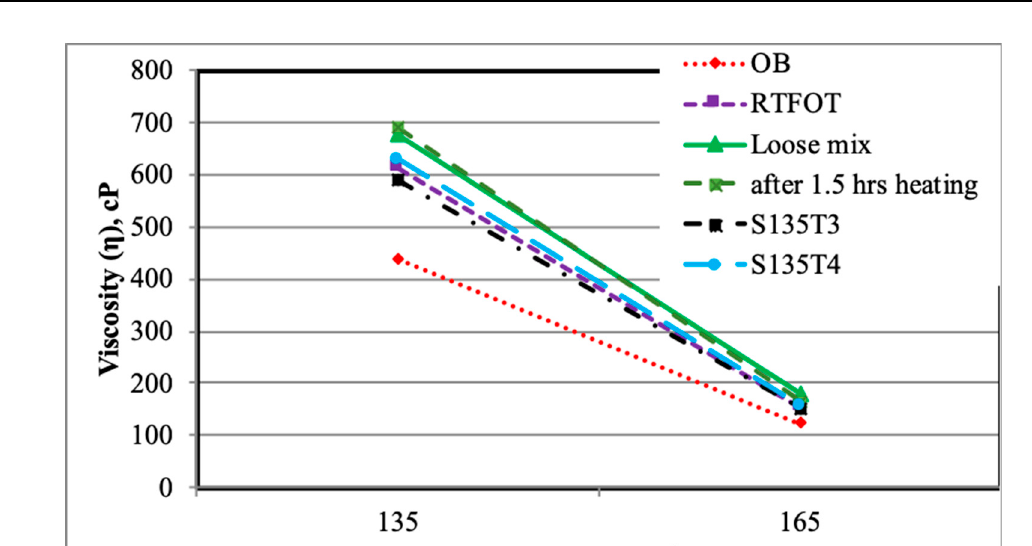
Figure 11. Comparison of viscosity results of unmodified binders recovered from mixture 2. Brookfield viscosity results of binders recovered from mixtures 1 and 2 showed that the viscosity increased with the increase of the duration of short-term aging as presented in Table 6 and Figures 10 and 11. The results also demonstrated that conditioning asphalt mixtures (mixtures 1 and 2) for 4 h at 135 °C was the closest condition to the viscosity results of asphalt binders extracted from loose mixtures (Figures 10 and 11). Furthermore, the true PG and MSCR test results showed that the conditioning mixtures at the same conditions at 135 °C for 4 h were close to those of loose mixtures, especially for mixture 2, while it was slightly off for mixture 1. A very similar result was obtained for mixture 3, that is, 4 h of conditioning the lab mixture closely simulated the RTFO-aged binder and the mixture from the field (Figure 12). Therefore, considering the results of the mechanical properties (dynamic modulus) and binder tests, conditioning asphalt mixtures at 135 °C for 4 h can adequately simulate the short-term aging of most asphalt mixtures used in the State of Qatar.